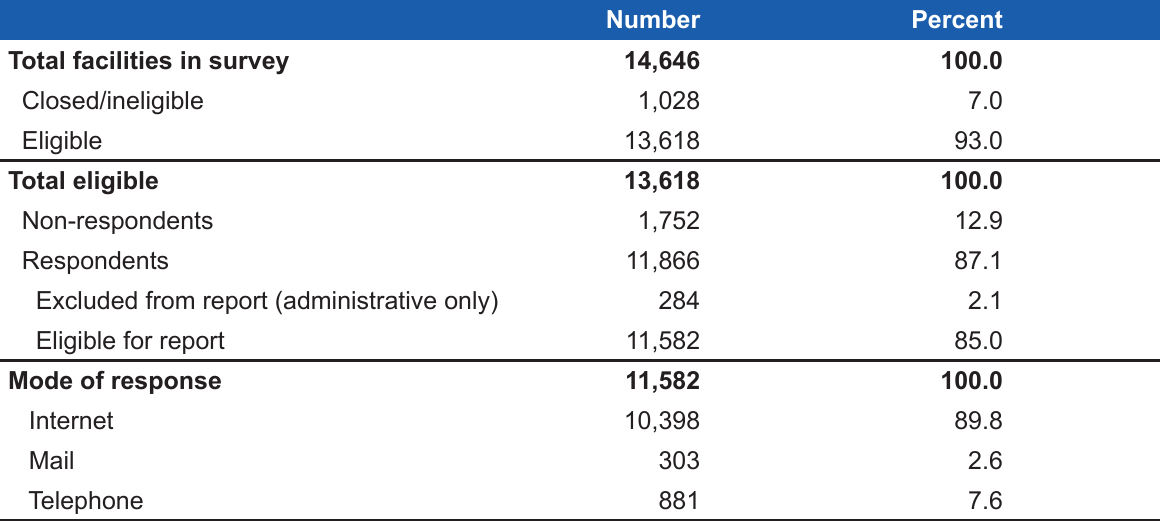
Table 1.1. N-MHSS facilities, by status and mode of response: